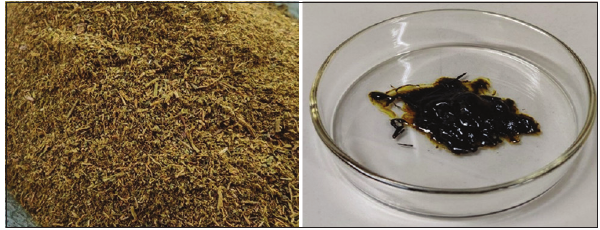
Figure-1: Typhonium flagelliforme leaves simplicia (left) and ethanol extract